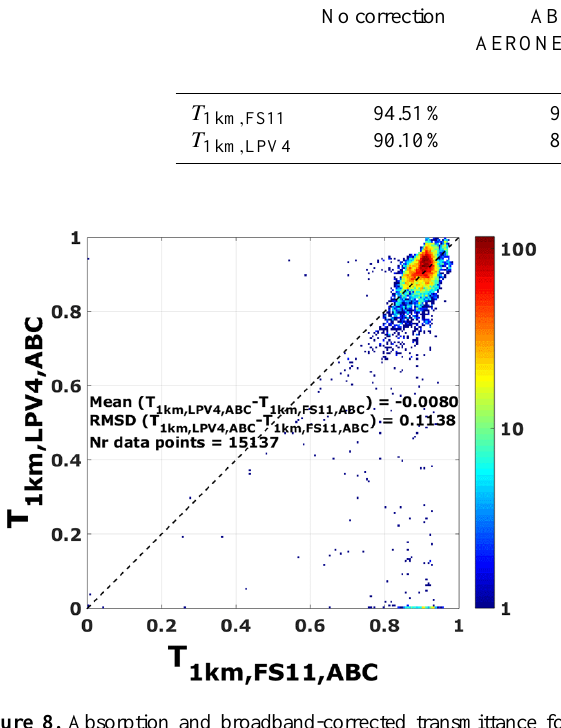
Figure 8. Absorption and broadband-corrected transmittance for 1km slant range measured by FS11 scatterometer and LPV4 trans- missometer. Input of standard aerosol profile “continental average” in ABC procedure. Color distribution displays the number of data points per grid point (logarithmic color